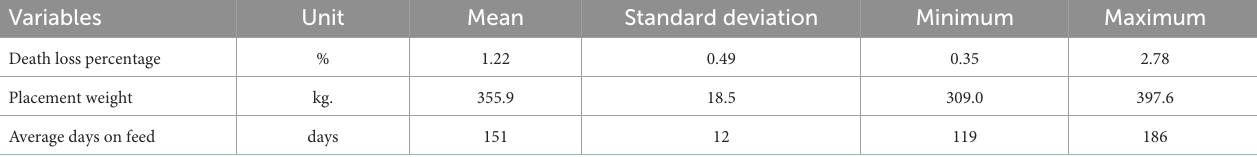
TABLE 1 Monthly death loss percentage, placement weight ∗ , and average days on feed for steers, Kansas feedlot summary, January 1992–July